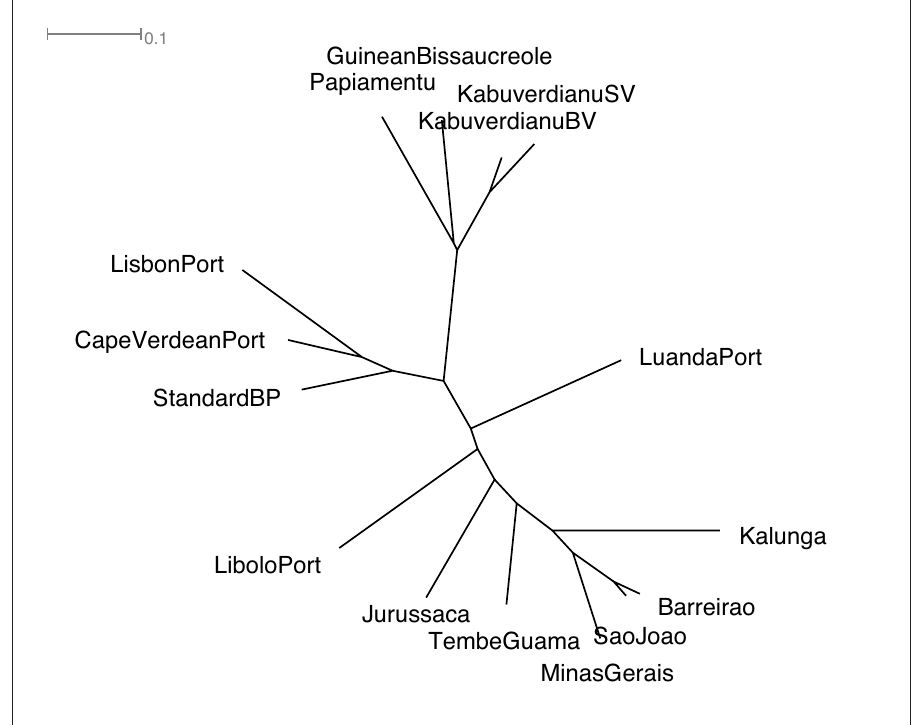
Figure 2: Split tree of a Neighbour-Joining Tree of 45 morphosyntatic dialectal features of 15 language